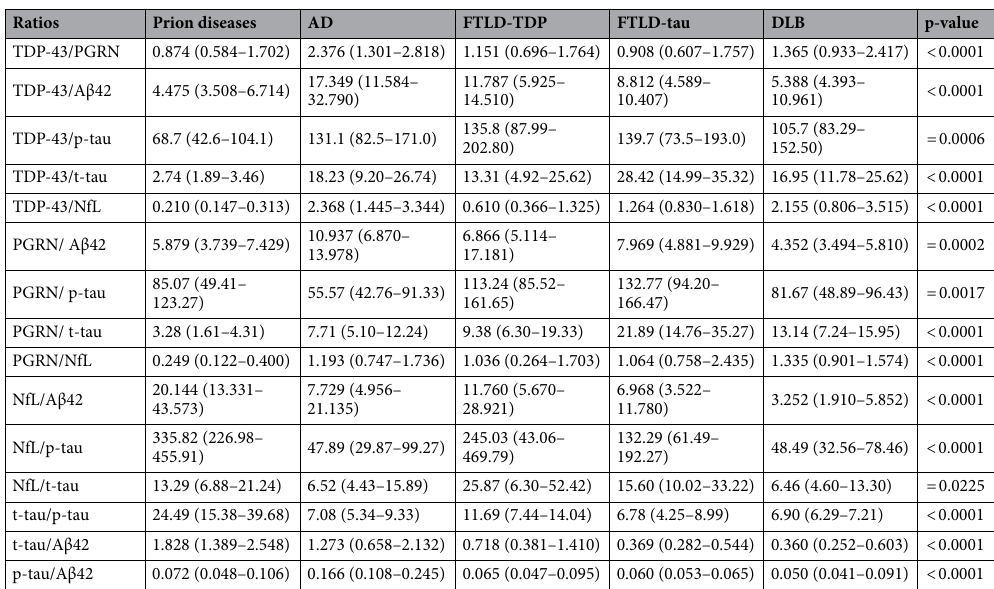
Table 2. Calculated ratios for prion diseases, Alzheimer’s disease (AD), frontotemporal lobar degeneration with TDP-43 inclusions (FTLD-TDP), frontotemporal lobar degeneration with tau inclusions (FTLD-tau), and dementia with Lewy bodies (DLB). Results are shown as medians with the interquartile range. P-values represent the approximate two-tailed p-values of the Kruskal–Wallis test when comparing all groups (p < 0.05). TAR DNA binding protein (TDP)-43; progranulin (PGRN); neurofilament light chain (NfL); total-tau (t-tau); phosphorylated-tau (181P) (p-tau); amyloid-beta (1–42)